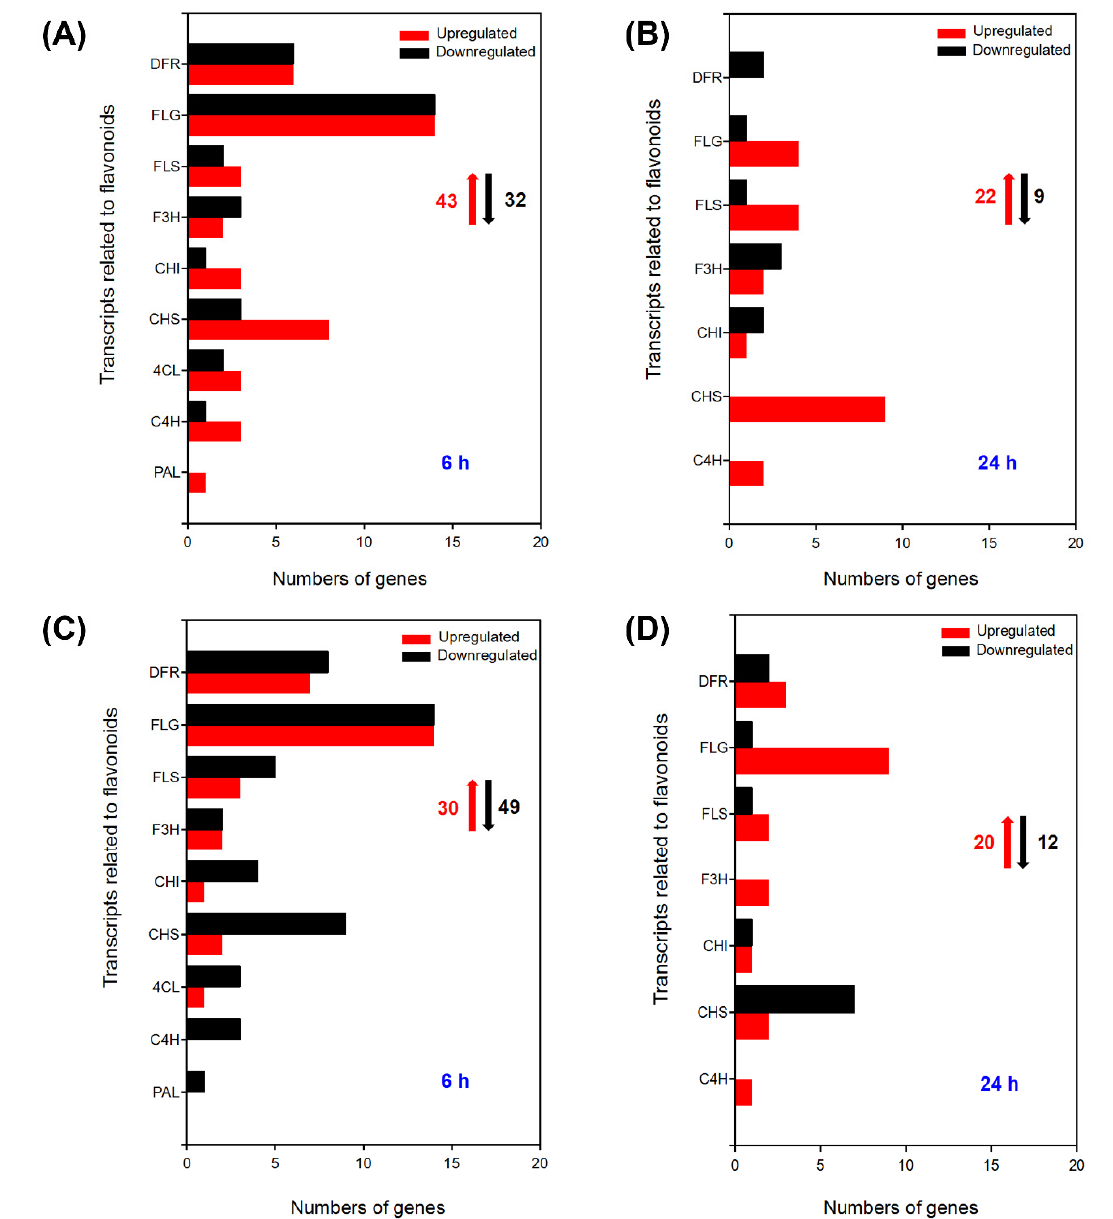
Figure 5. Number of DEGs related to flavonoids under 100 mM NaCl treatment for 6 h and 24 h in leaves ( A , B , respectively) and in roots ( C , D , respectively) of A. canescens . FLG: flavonoid 3-O-glucosyltransferase, DFR: dihydroflavonol-4-reductase, FLS: flavonol synthase, F3H: flavanone 3-hydroxylase, CHI: chalcone isomerase, CHS: chalcone synthase, 4CL: 4-coumarate-CoA ligase, C4H: cinnamate 4-hydroxylase, PAL: phenylalanine ammonialyase. The red upward arrows and black downward arrows indicate the total number of upregulated DEGs and downregulated DEGs, respectively. In A. canescens leaves, as many as 286 TF genes were differentially expressed after expo- sure to 100 mM NaCl for 6 h, including 226 upregulated DEGs and 60 downregulated DEGs (Figure 6A; Figure S3A). The transcripts predicted to encode WRKY1, WRKY20, WRKY56, and NAC29 were identified as upregulated, which were proved to play definite and key roles in plant salt tolerance (CL3186.Contig1_All, Unigene6298_All, Unigene1538_All, and Unigene3810, respectively) (Table S13). The largest proportion of upregulated DEGs were ZFs, containing some C 2 H 2 -type ZFs (CL647.Contig3_All, CL7175.Contig1_All, Uni- gene1480_All, and Unigene251_All) (Figure 6A, Table S13). DREBs